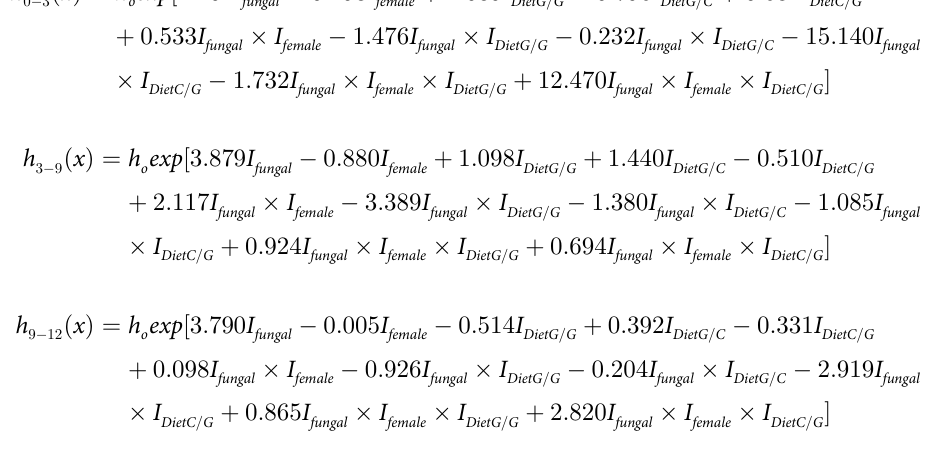
Experiment 4: Effects of yeast supplementation on sexual dimorphism in post-infection survival of D . melanogaster inoculated with B . bassiana strain GHA. The cornmeal and glucose diets used in Experiment 3 differ in their nutrients. The cornmeal diet has a much higher sugar content than the glucose diet. Comparatively, the overall protein to carbohydrate ratio for the glucose diet is 1:4, whereas cornmeal is 1:9, as calculated by the Drosophila Die- tary Composition Calculator [18]. Yeast supplementation can provide a source of high protein.